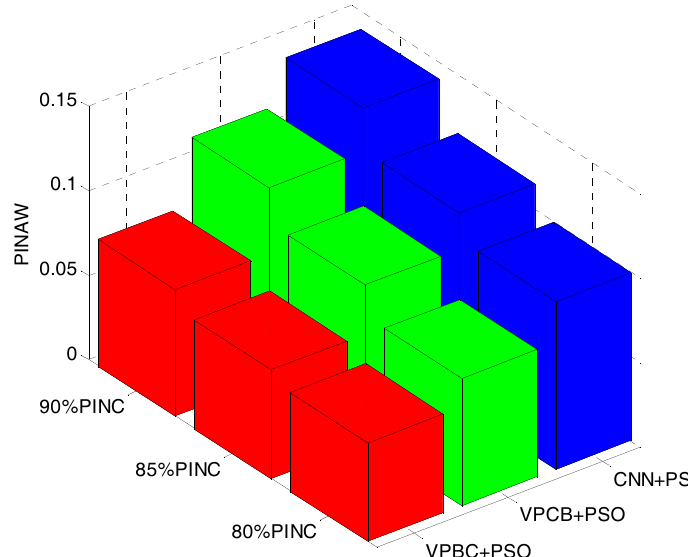
Figure 16. Comparison of the PINAW indices of the different methods.